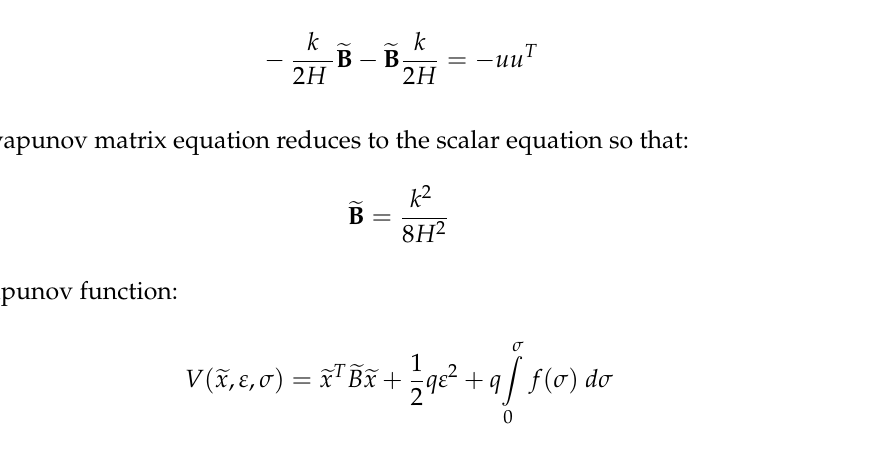
Figure out the symmetric positive definite matrix (cid:101) B by solving the Lyapunov matrix